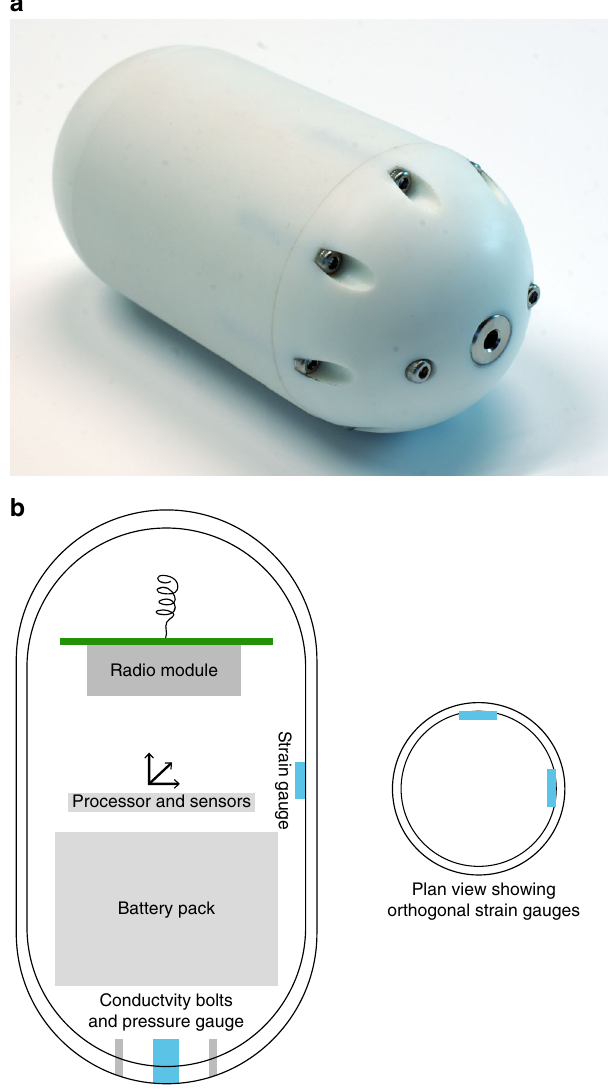
Fig. 2 Glacsweb wireless probe details: a photograph of the 2012 probe; b probe schematic (dimensions: length 0.16 m, width 0.06